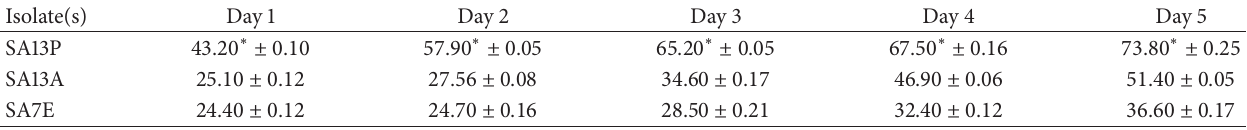
Table 1: Decolorization (%) of Malachite Green by various isolates.